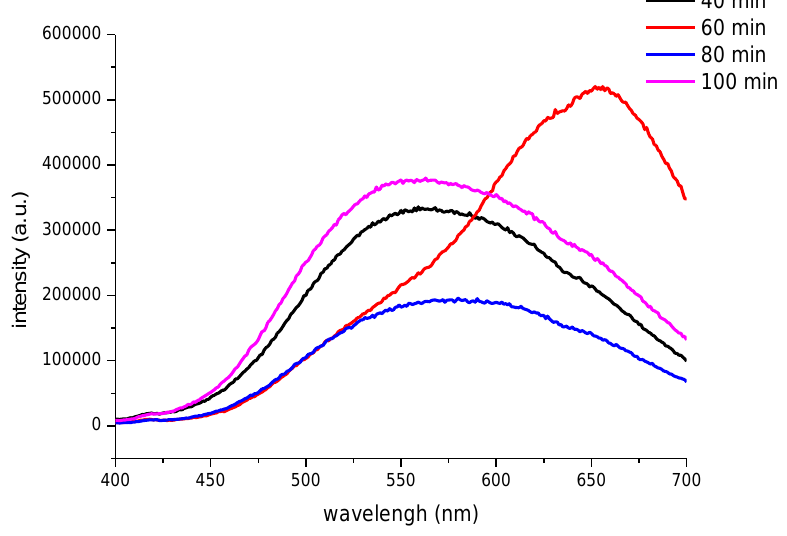
Figure 7. The PL spectra of the CNF/CdS nanocomposites with different maturing time (excitation wavelength 365 nm).